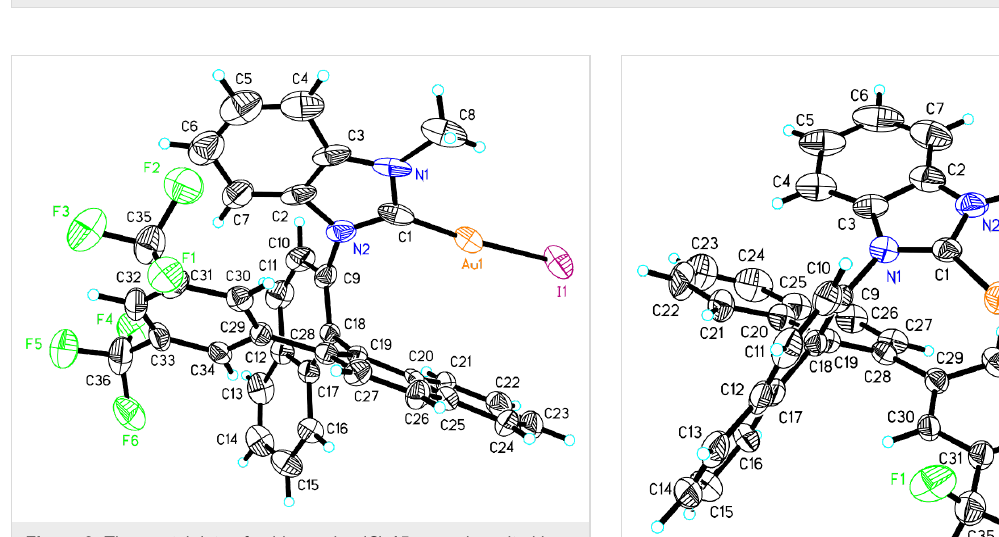
Figure 2: The crystal data of gold complex ( S )- 15a was deposited in the CCDC with the number 883917. Empirical formula: C 36 H 22 AuF 6 IN 2 ; formula weight: 920.42; crystal color, colorless; crystal dimensions: 0.321 × 0.212 × 0.143 mm; crystal system: orthorhombic; lattice parameters: a = 9.6909(5) Å, b = 18.5814(9) Å, c = 36.0427(18) Å, α = 90 o , β = 90 o , γ = 90 o , V = 6490.2(6) Å 3 ; space group: P 2(1)2(1)2(1); Z = 8; D calc = 1.884 g/cm 3 ; F 000 = 3504; final R indices [I > 2sigma(I)]: R1 = 0.0421; wR2 = 0.0793.